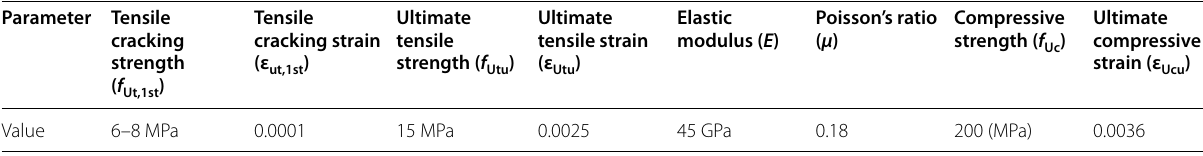
Table 1 Parameters for the simplified constitutive model of UHPC. Parameter Tensile cracking